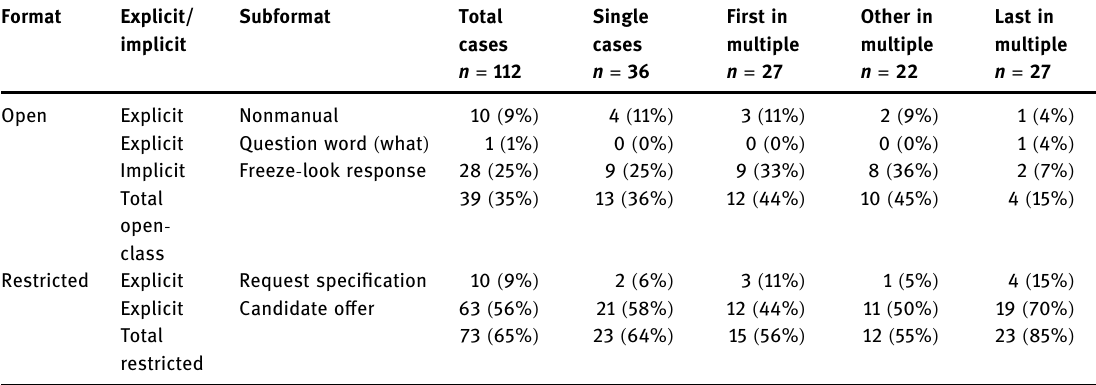
Table 1: Distribution of di ff erent formats for repair initiation in the total NTS data and in four sequential positions